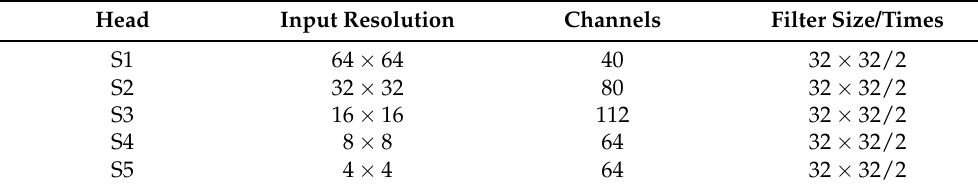
Table 1. Lightweight Pyramid Head